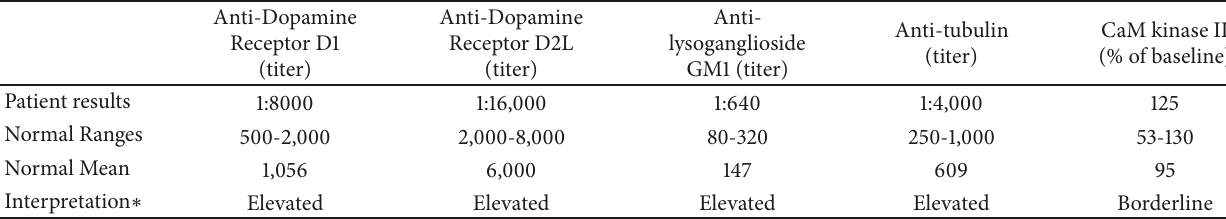
Table 1: Results of patient A’s anti-neuronal antibody